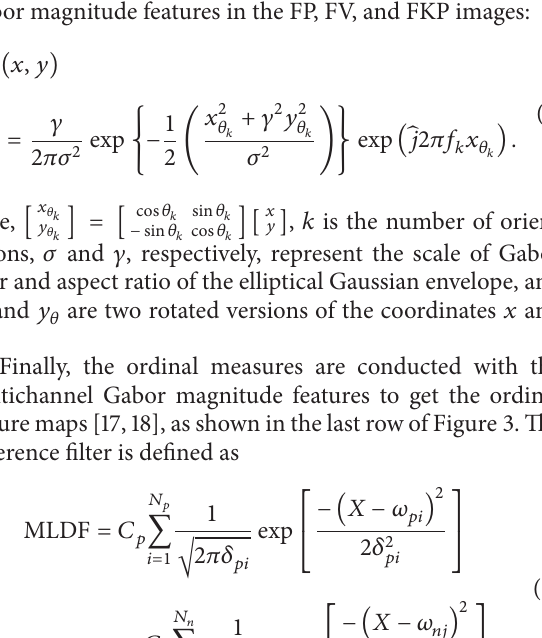
blurred images, as shown in the middle row of Figure 3.